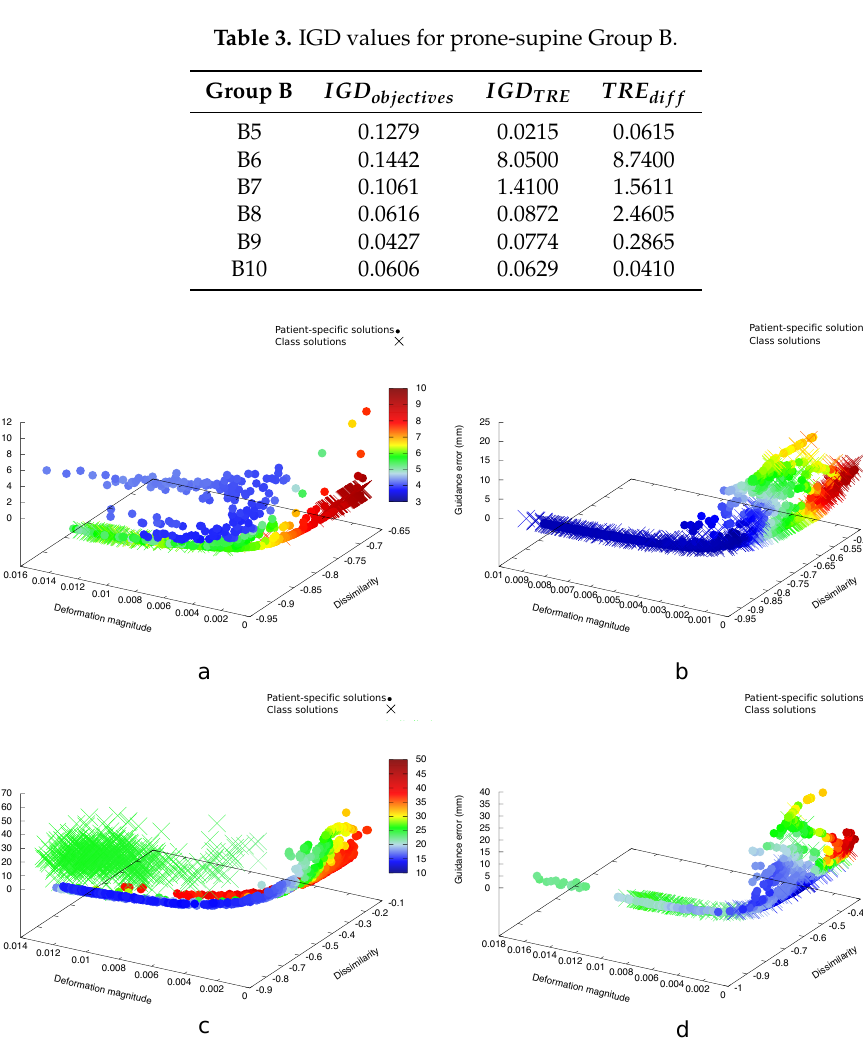
Figure 6. Non-dominated fronts of patient-specific solutions and their class solutions for prone-supine Test Cases A1 ( a ), A2 ( b ), B6 ( c ) and B9 ( d ), colour coded with the mean TRE in mm. The colour scales are different for each case, to illustrate the different TRE distributions